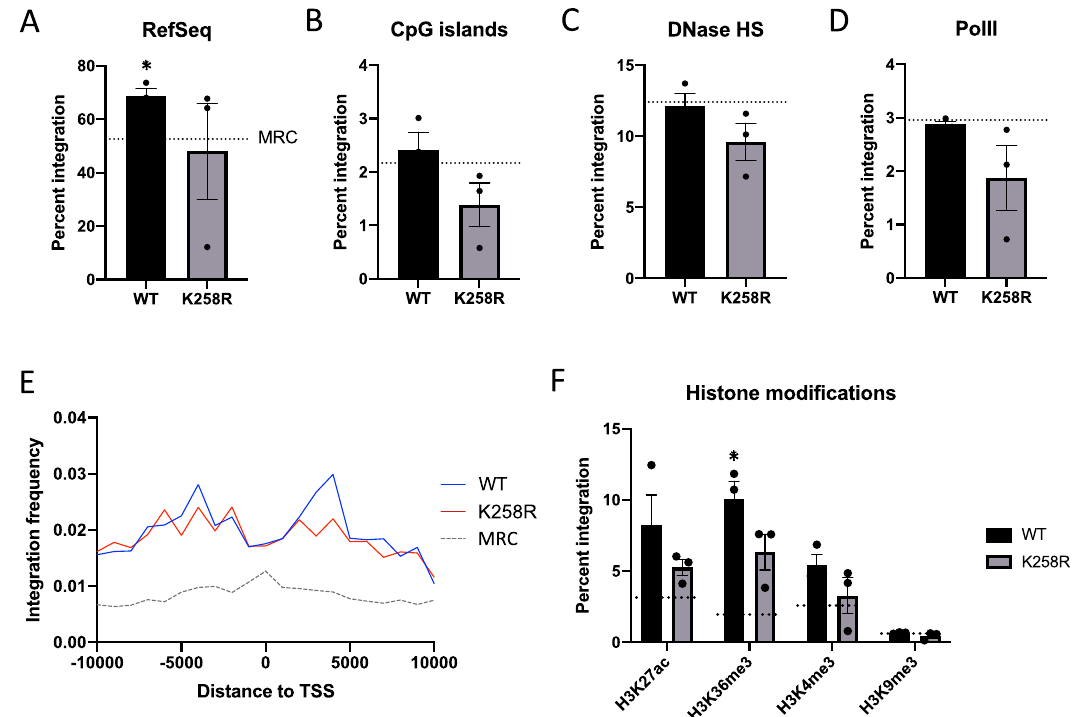
Fig. 2 The K258R mutation in IN has minimal effect on integration site distribution into low-copy number sequences. Integration sites were mapped to the GRCh38 human reference genome assembly using Bowtie end-to-end alignment. Frequency of integrations falling within ( A ) RefSeq genes, or within 1 kb of ( B ) CpG islands, ( C ) DNase hypersensitivity sites, and ( D ) RNA polymerase II binding sites was calculated using BedTools. The frequency of integrations expected to be located near these features by random chance (matched random control, MRC) is shown as a dashed line. E Distribution of